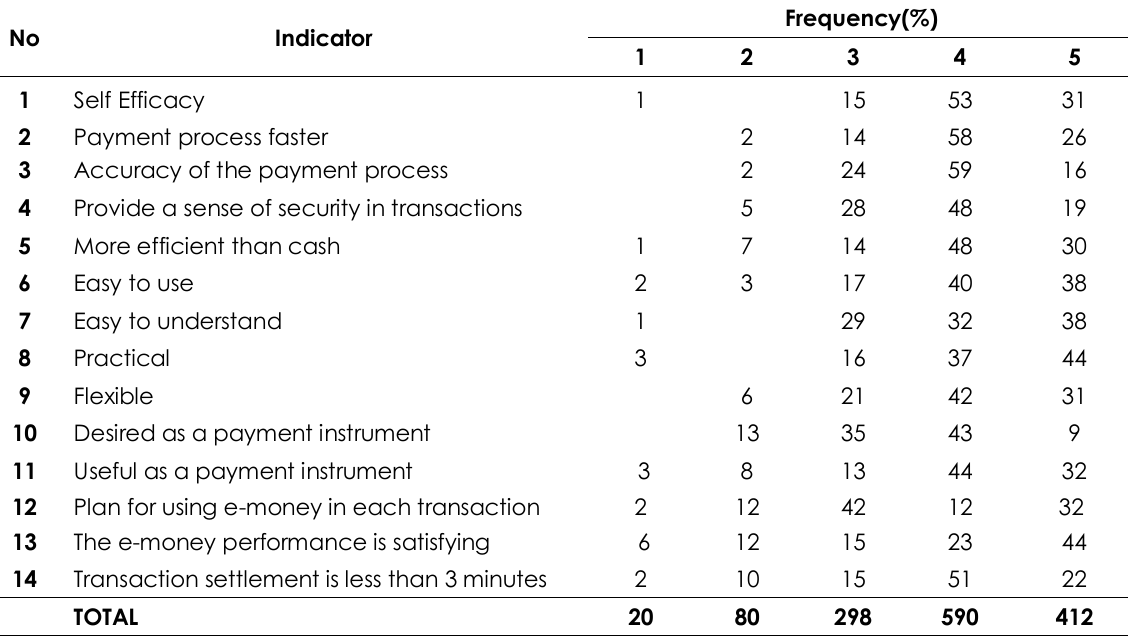
Table 1. Recapitulation of the